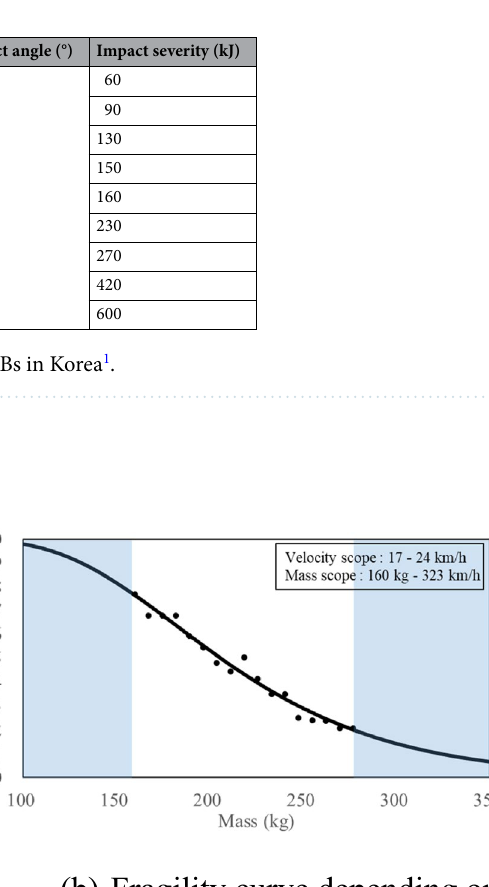
Figure 14. Presented fragility curves under same local impact energy 3.6 kJ